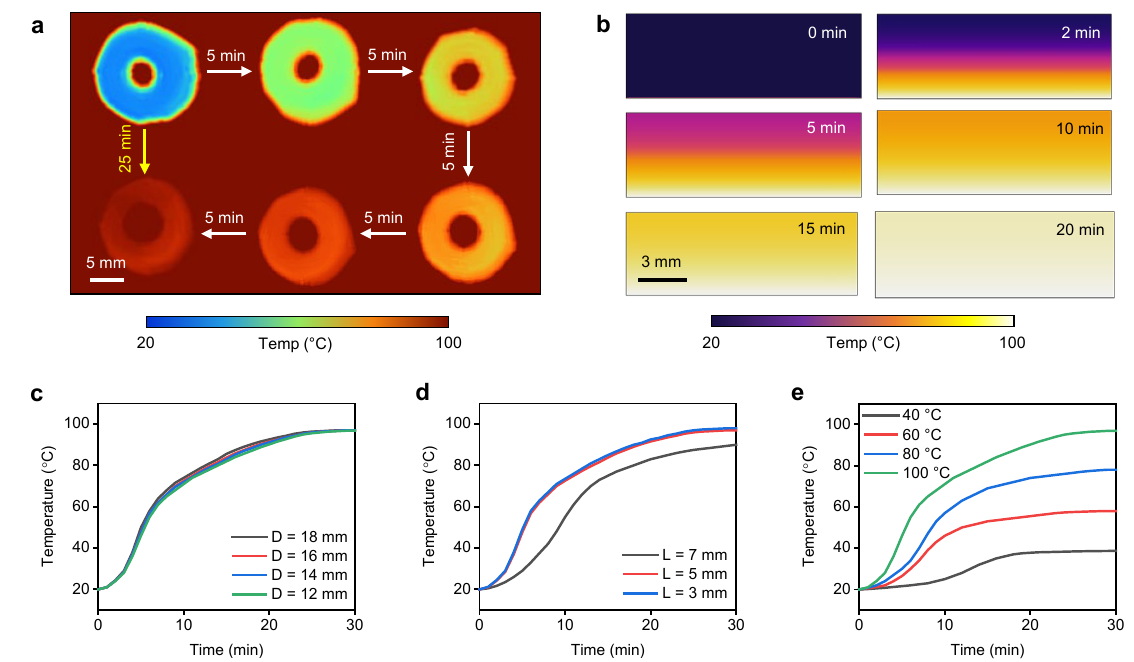
Figure 5. Thermal actuation of the PAHV. ( a ) IR images exhibiting the PAHV’s actuation at 100 ◦ C. ( b ) FE simulations showing heat transfer in the PAHV when actuated at 100 ◦ C. ( c ) Temperature changes in PAHVs ( L = 5 mm) of different diameters (12–18 mm) when actuated at 100 ◦ C. ( d ) Temperature changes in PAHVs ( D = 12 mm) of different lengths (3–7 mm) when actuated at 100 ◦ C. ( e ) PAHV temperature changes ( D = 12 mm, L = 5 mm) when actuated at different temperatures (40–100 ◦